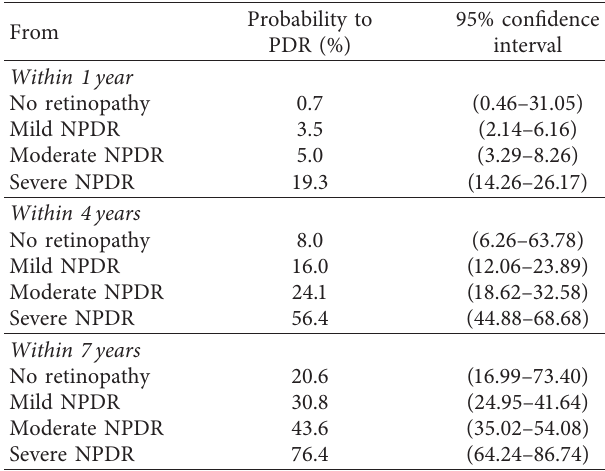
Table 8: Probability of transitioning to proliferative diabetic ret- inopathy within 1, 4, and